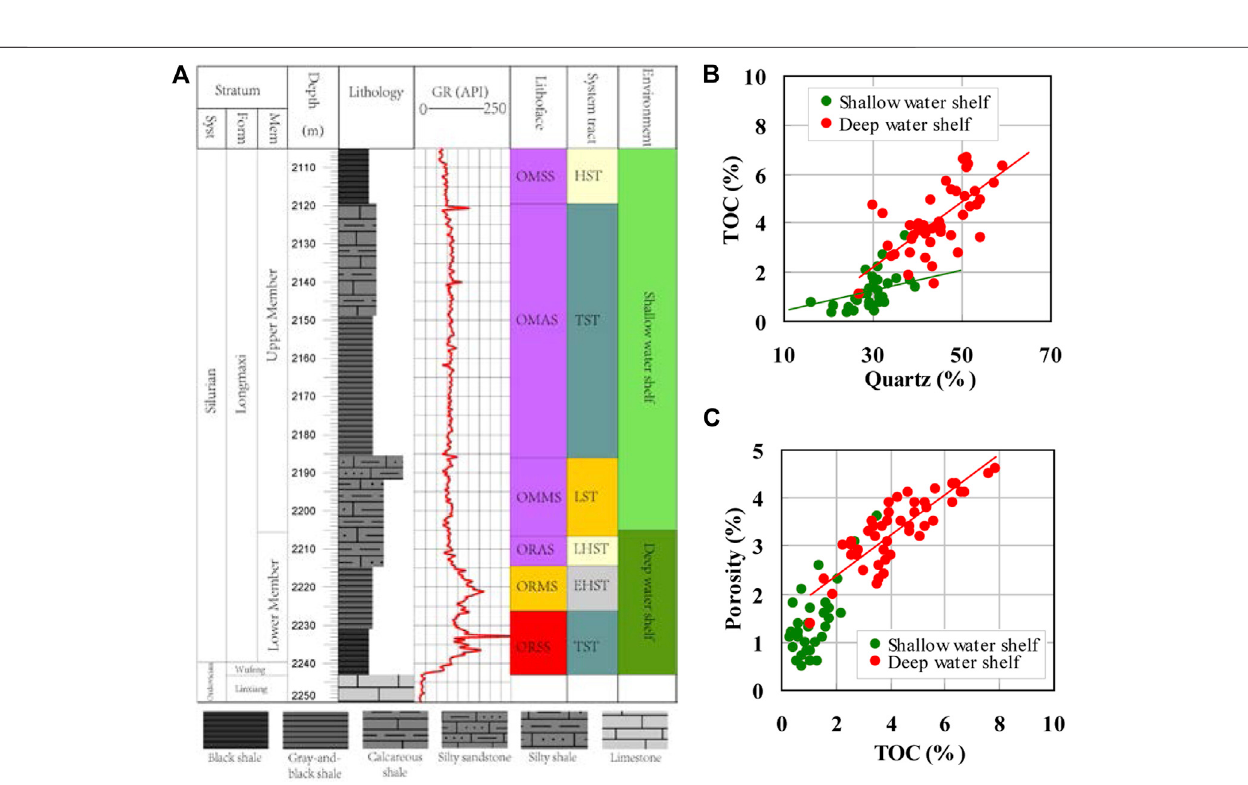
FIGURE 2 | (A) Sequence stratigraphic framework of Wufeng-Longmaxi Formation shale. ORSS: Organic-rich siliceous shale; ORMS: Organic-rich mixed shale; ORAS: Organic-lean argillaceous shale; OMSS: Organic-moderate siliceous shale; OMMS: Organic-moderate mixed shale; OMAS: Organic-moderate argillaceous shale. TST:transgressive systems tract; EHST: early highstand systems tract; LHST: late highstand systems tract (LHST); LST: low stand system tract; HST: highstand systems tract. (B) Relationship of TOC content and quartz content. (C) Relationship of TOC content and porosity. Data are sorted by sedimentary circumstance.